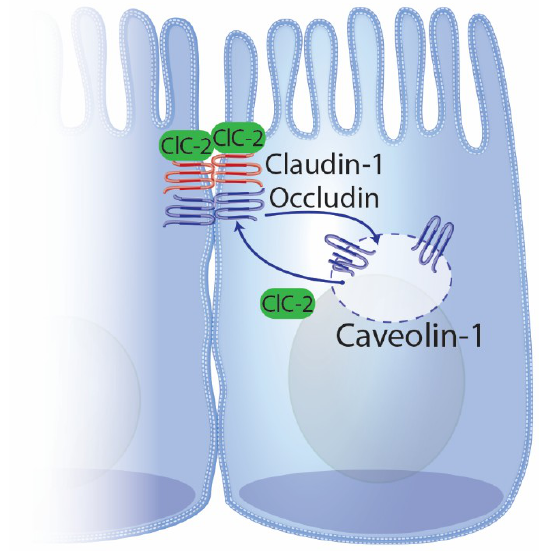
ffi cking of occludin.